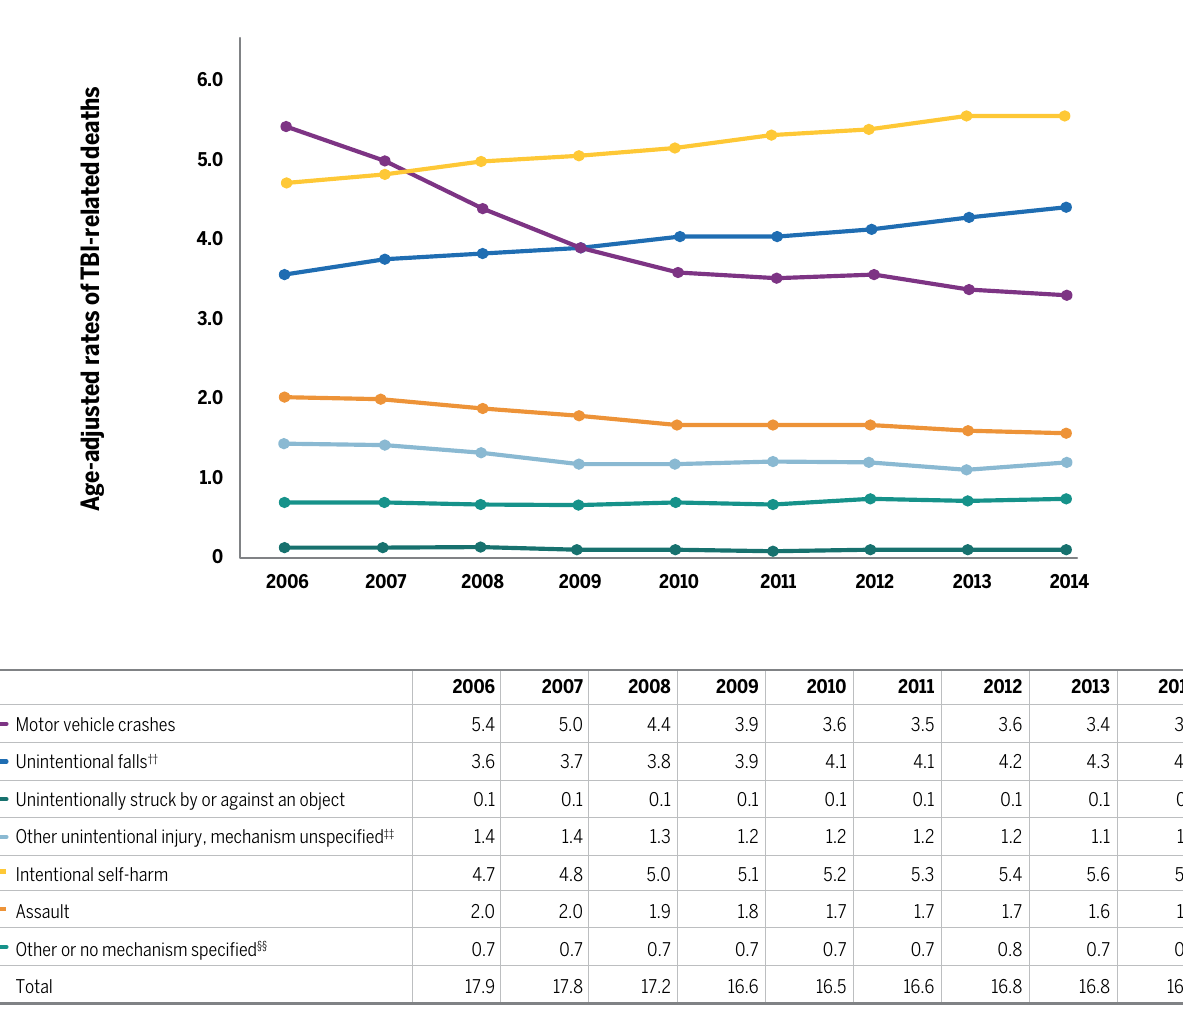
FIGURE 4A: AGE-ADJUSTED RATES ¶ , PER 100,000 POPULATION, OF TRAUMATIC BRAIN INJURY–RELATED DEATHS, BY YEAR AND MECHANISM OF INJURY,